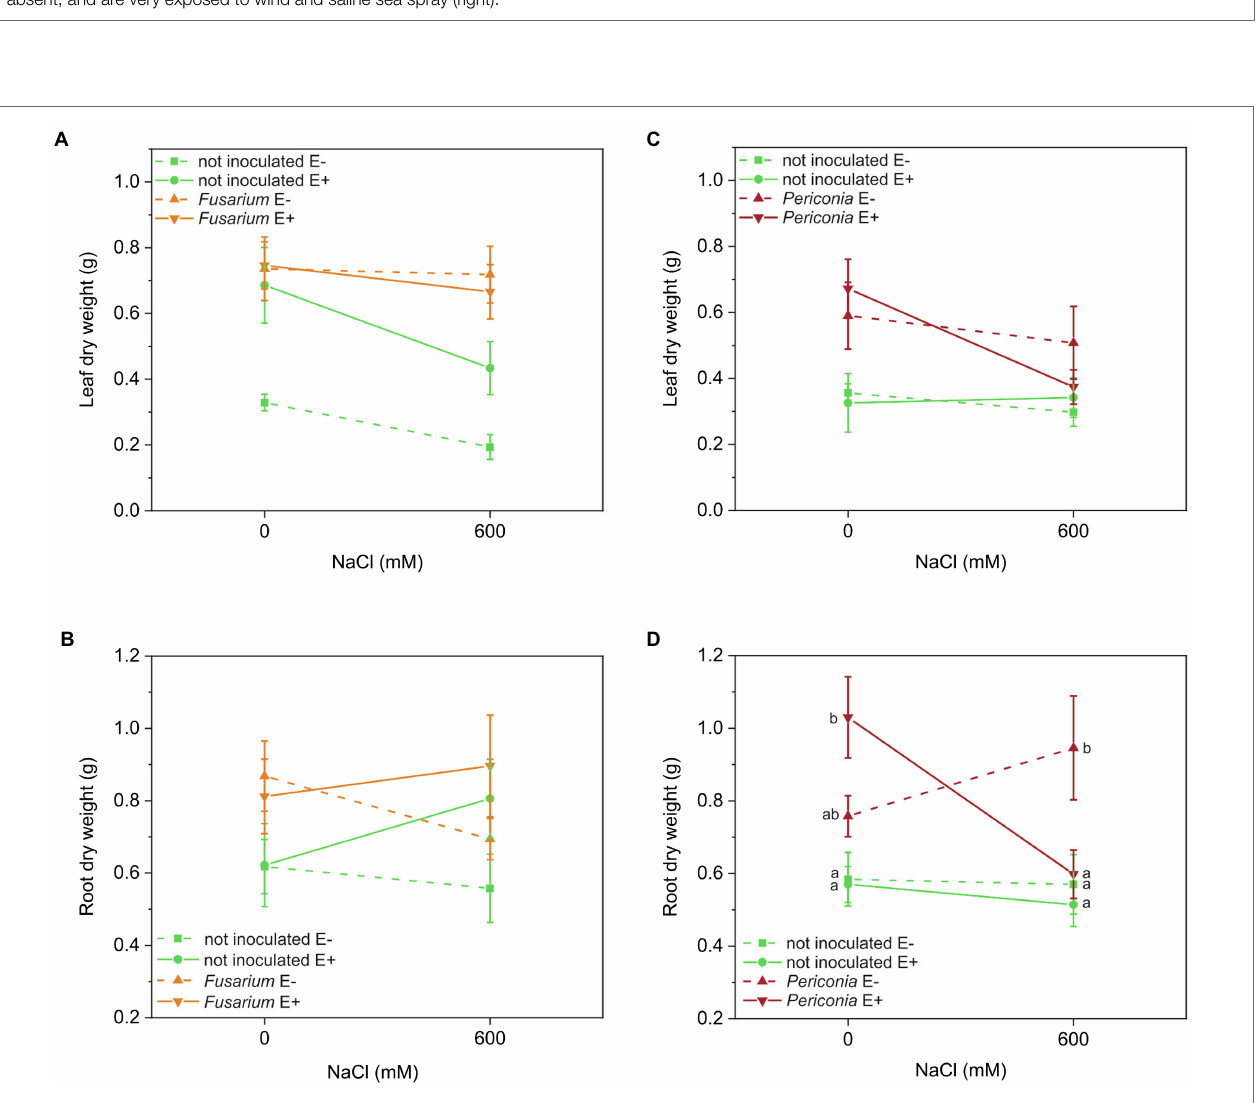
FIGURE 1 | Festuca rubra subsp. pruinosa (FRP) inhabits rocky sea cliffs of the Atlantic coasts of Europe (left). Plants often grow in rock fissures, where soil is absent, and are very exposed to wind and saline sea spray